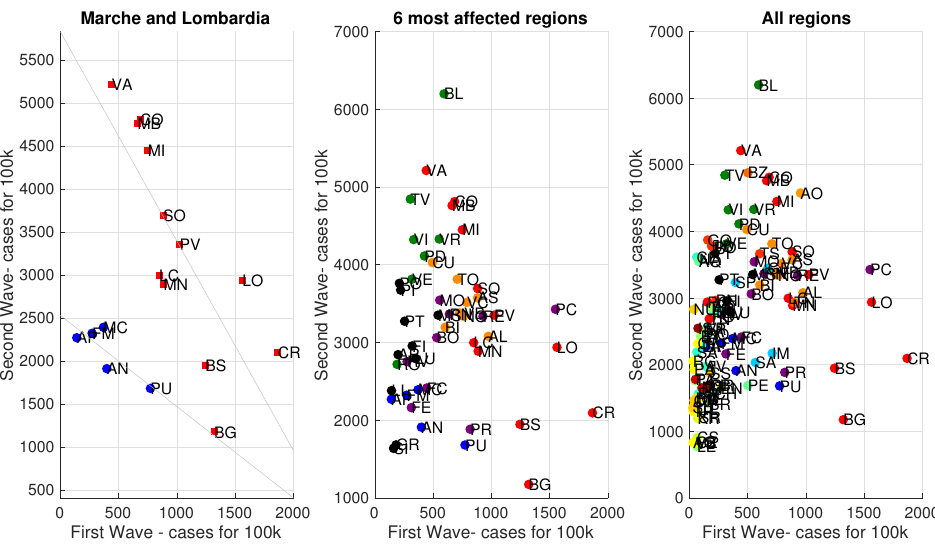
Figure 2. Daily cases per 100k people in Marche and Lombardia. Note: this figure displays the correlation between intensity of the COVID-19 first wave, measured as cumulative number of daily cases per 100 thousand people between 24 February 2020 and 16 July 2020, and the second wave, measured as cumulative number of daily cases per 100 thousand people between 17 July to 28 December. The left panel reports the correlation for the provinces in Marche (blue dots) and Lombardia (red squadred), and the two regression lines. The central panel reports the correlation for the provinces in the six most infected regions (Lombardia, Emilia-Romagna, Veneto, Piemonte, Marche and Toscana). The right panel reports the correlation for all the Italian provinces. Provinces of the same region share the same